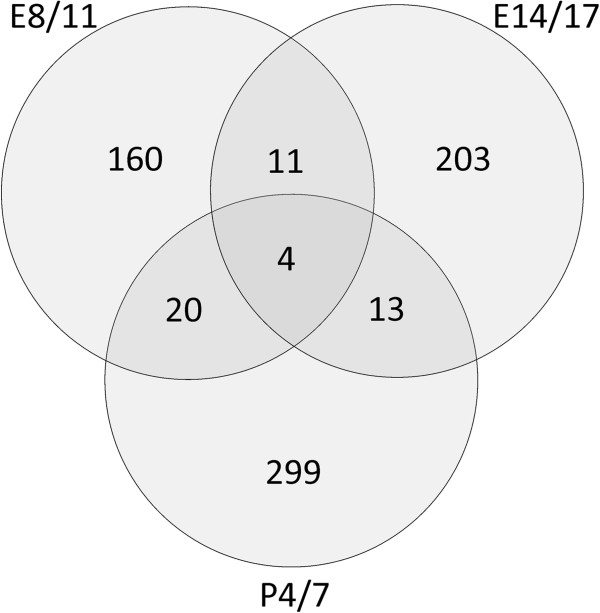
Venn diagram indicating the number of differentially expressed genes identified by each treatment paradigm (E8/11, E14/16, P4/7), including the number of genes that overlapped between multiple treatments.